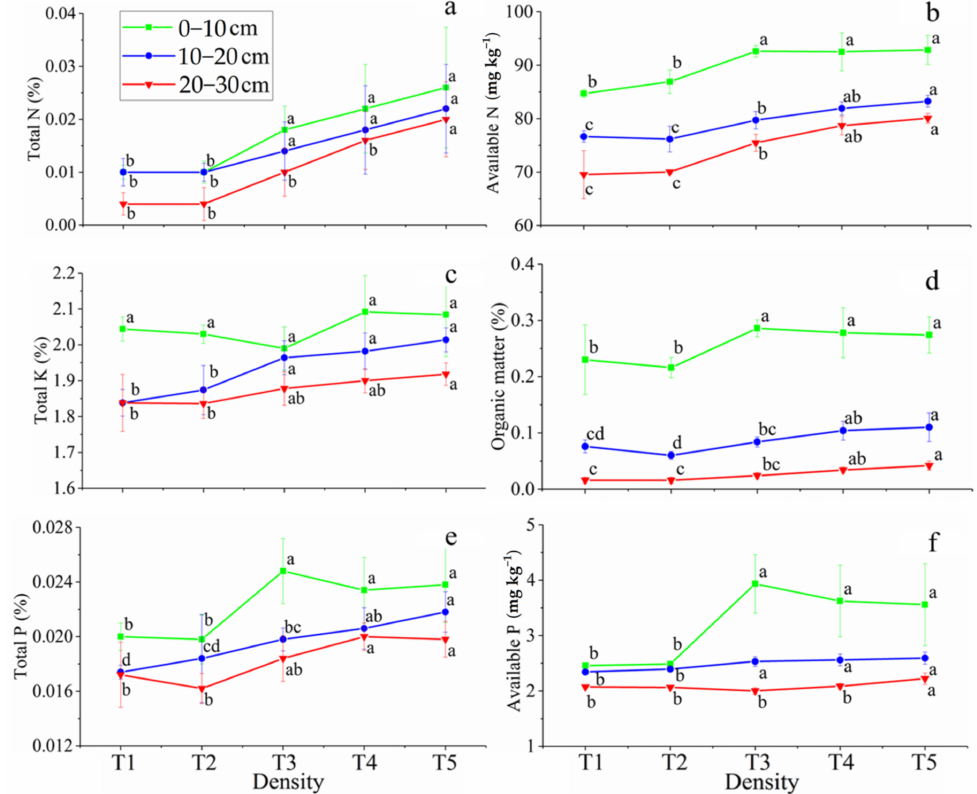
Figure 4. Soil nutrient traits included Total N ( a ), Available N ( b ), Total K ( c ), Organic matter ( d ), Total P ( e ) and Available P ( f ) in the 0–10, 10–20, and 20–30 cm soil layers under the five population densities. The different letters for each line in each panel denote the significant differences ( p < 0.05) among the five